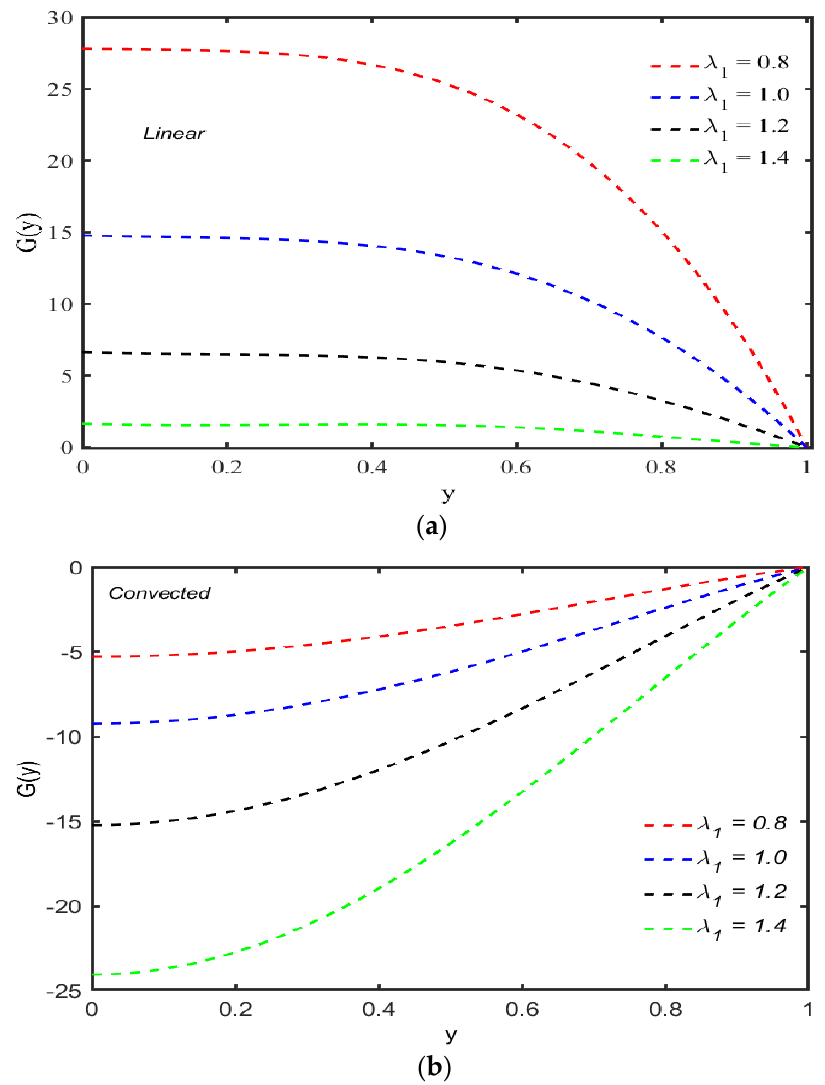
Figure 2. ( a ) Change in G ( y ) for several values of λ 1 with R = 10, χ = 0.3, α = 0.5. ( b ) Change in G ( y ) for several values of λ 1 with R = 10, χ = 0.3, α =